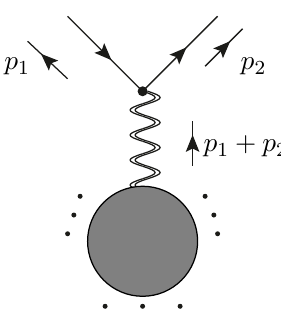
Figure 12 . Feynman diagrams leads to collinear gaugino